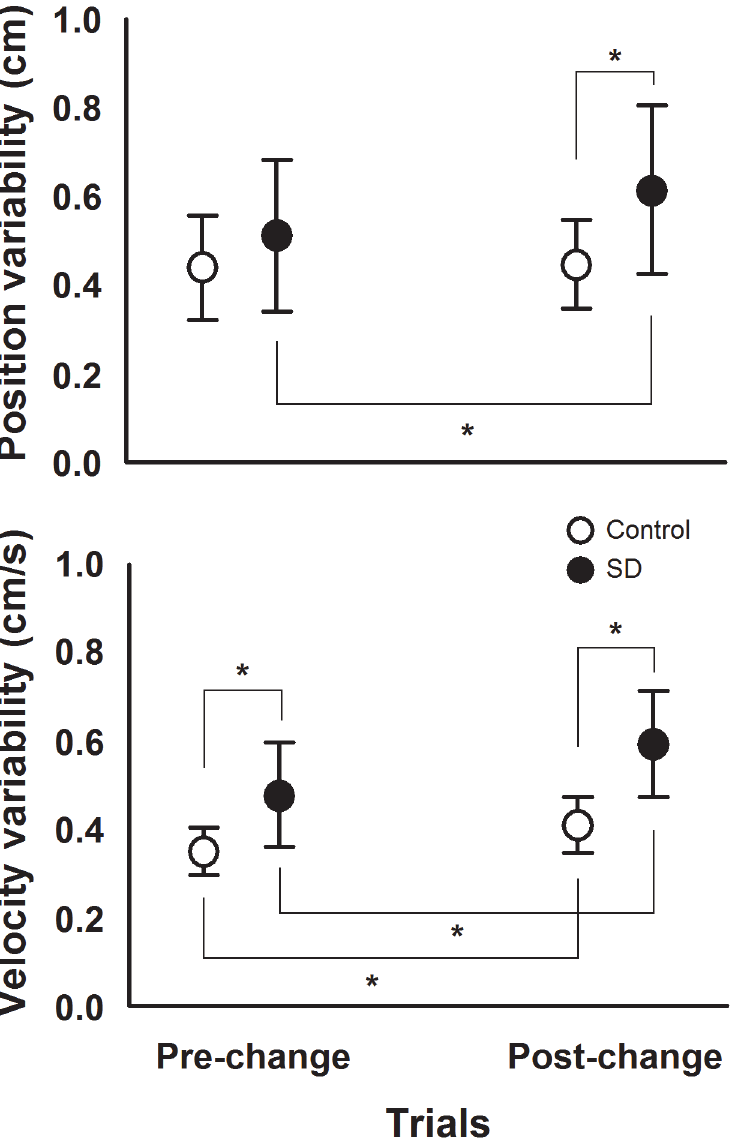
Fig 6. Mean and standard deviation values of position and velocity variability in pre- and post-change trials for both sleep deprivation (SD) and control groups. Note: ( * ) represent significant pairwise comparisons, which was used for group x trial interaction for both position and velocity